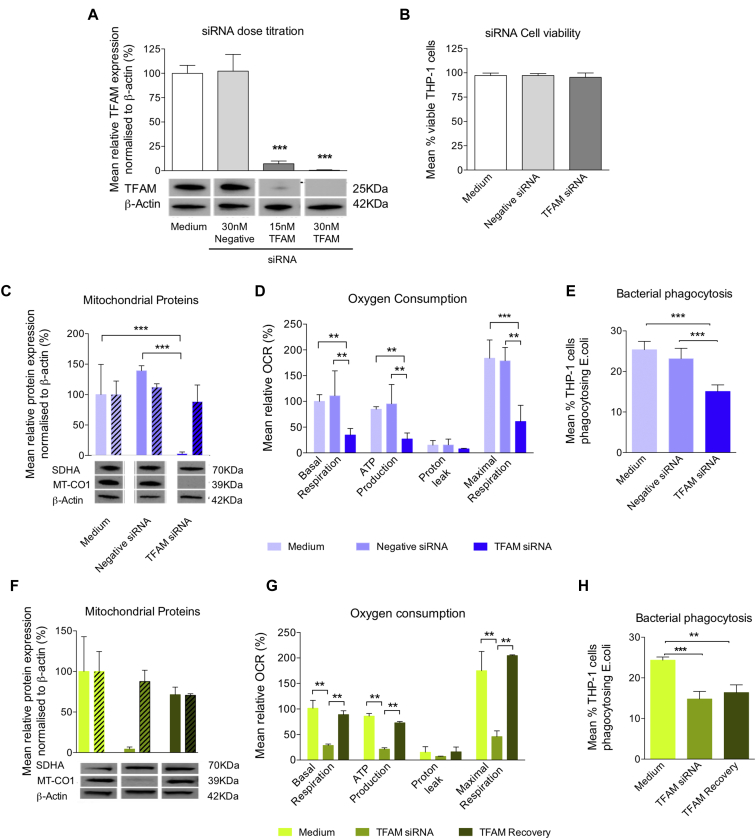
MtDNA depletion and impaired immune functions and subsequent recovery in THP-1 cells following transfection with TFAM siRNA. A-G, Transfection with TFAM siRNA. A, TFAM proteins levels relative to β-actin during titration of TFAM siRNA, showing optimal knockdown of TFAM protein after transfection of THP-1 cells with 30 nmol/L siRNA for 8 days. B, Cell viability. C, Cell proliferation. D, The levels of the MT-CO1 and SDHA proteins relative to β-actin. D, OCR for different aspects of mitochondrial respiration and respiratory profile. E, Phagocytosis of E coli. Recovery 8 days after removal of TFAM siRNA. F, Levels of the MT-CO1 and SDHA proteins relative to β-actin. G, Oxygen consumption for different aspects of mitochondrial respiration. H, Bacterial phagocytosis. All experiments were carried out on 3 to 4 independent biological replicates and are presented as means ± SD. **P < .01 and ***P < .001.